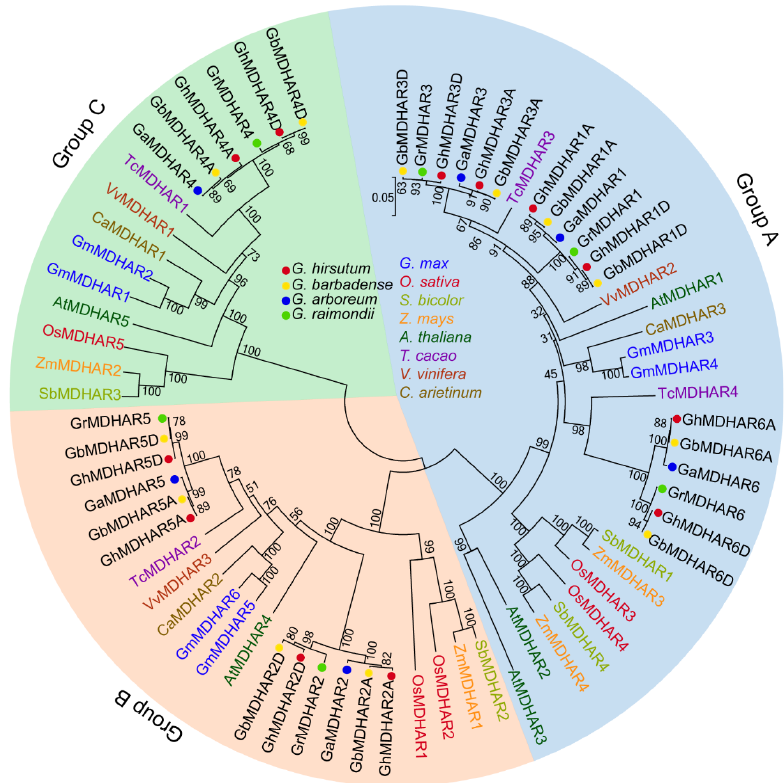
Figure 2. Phylogenetic analysis of MDHAR family genes in cotton and other plant species. A total of 70 MDHAR protein sequences from the four cotton species of G. arboreum (GaMDHARs),